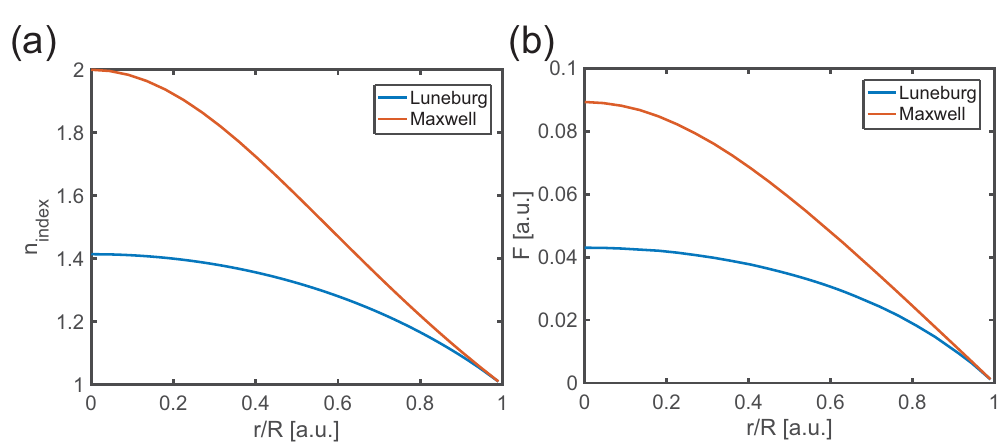
Figure 5. ( a ) Refractive index profile of the Luneburg lens and the Maxwell lens. ( b ) Calculated interaction coefficient profile for a Luneburg lens and a Maxwell